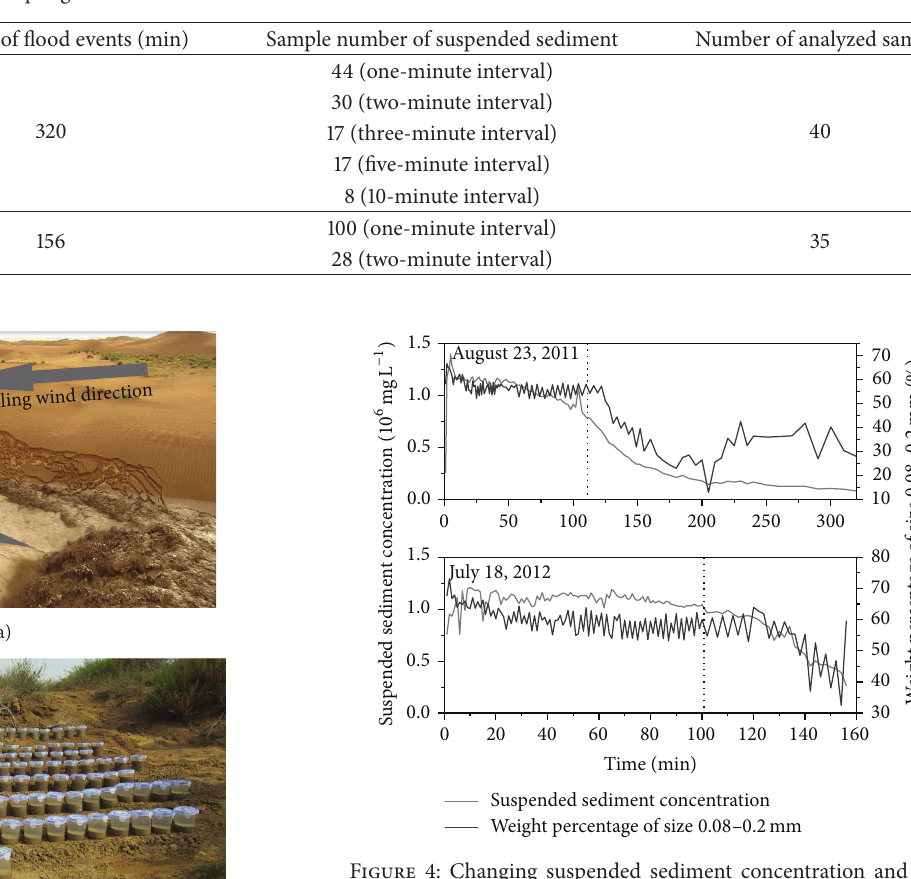
Figure 4: Changing suspended sediment concentration and size fraction of the suspended sediment during the two flood events in the Sudalaer desert